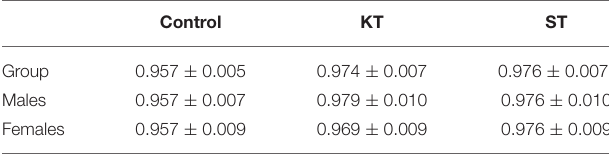
TABLE 3 | Effects of taping measured with the Minkowski-Bouligand method. TABLE 4 | Effect of taping measured by the box-counting